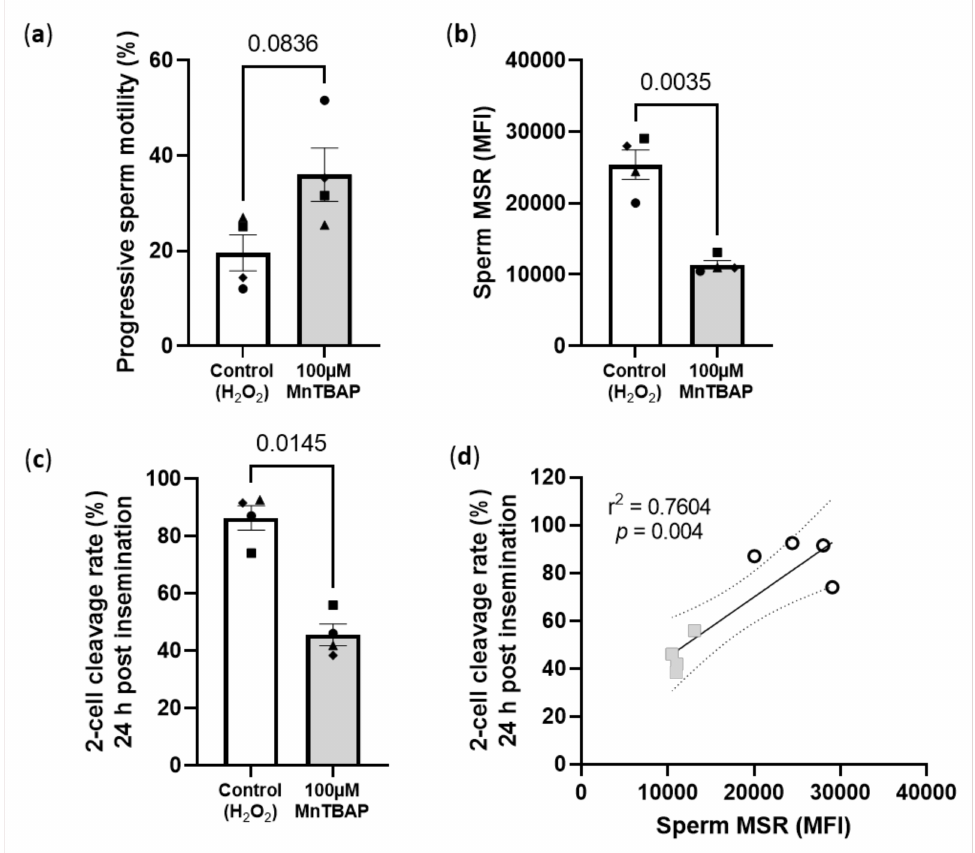
Figure 3. Reducing sperm mitochondrial superoxide concentrations with 100 µ M MnTBAP in a mouse model of in vitro H 2 O 2 exposure significantly impairs 2-cell embryo development. ( a ) Pro- portion of sperm with progressive motility; ( b ) Sperm mitochondrial superoxide mean fluorescence intensity (MFI) (MitoSox Red, (MSR) a specific mitochondrial superoxide indicator); ( c ) Proportion of 2-cells 24 h post insemination with 10,000 sperm and ( d ) Linear regression of sperm superoxide concentrations and 2-cell cleavage rates (grey squares: 100 µ M MnTBAP, white circles: 3000 µ M H 2 O 2 ). Data is representative of 4 CBAF1 males (represented by different symbols on graphs) and 24 super ovulated 3–4 weeks old CBAF1 females. Female mice were super ovulated with 5IU of PMSG followed 48 h with 5IU of HCG. Sperm was collected from male mice 15 h post HCG and incubated in 3000 µ M of H 2 O 2 in G-IVF PLUS (Vitrolife) for 1 h at 37 ◦ C, 5% O 2 and 6% CO 2 . Sperm samples were split into two groups and either incubated in (1) Control: 3000 µ M of H 2 O 2 in G-IVF PLUS or (2) 100 µ M of MnTBAP: 3000 µ M of H 2 O 2 in G-IVF PLUS for a further 1 h at 37 ◦ C, 5% O 2 and 6% CO 2 . Cumulus oocyte complexes (COC) were collected from female mice 15.5 h post HCG. Sperm were washed of their treatments after backfilling with 3 mL of G-IVF PLUS by centrifugation 400 × g for 5 min. COCs were inseminated with 10,000 sperm 16.5 h post HCG. Following a 4 h fertilization, zygotes were washed and cultured in G1 PLUS (Vitrolife) for 24 h at 37 ◦ C, 5% O 2 and 6% CO 2 at which 2-cell embryo cleavage rates were assessed. Prior to insemination, sperm progressive motility was assessed in 200 sperm per sample and superoxide concentrations assessed after 30 min incubation at 37 ◦ C of 5 µ M of MSR and 10,000 sperm assessed on a FACS Canto II. Data was analysed by a paired t-test or a simple linear regression showing the slope and 95% confidence